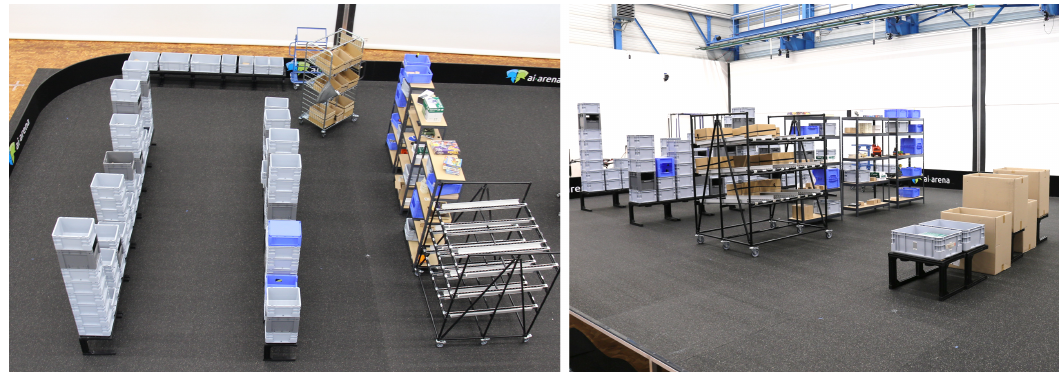
Figure 5. Physical laboratory set-up of logistics Scenario 2—real warehouse order